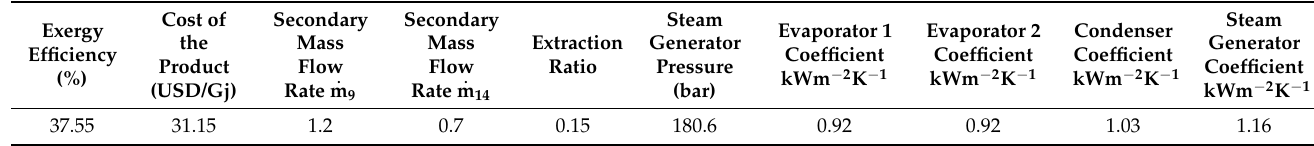
Table 14. Selected optimal